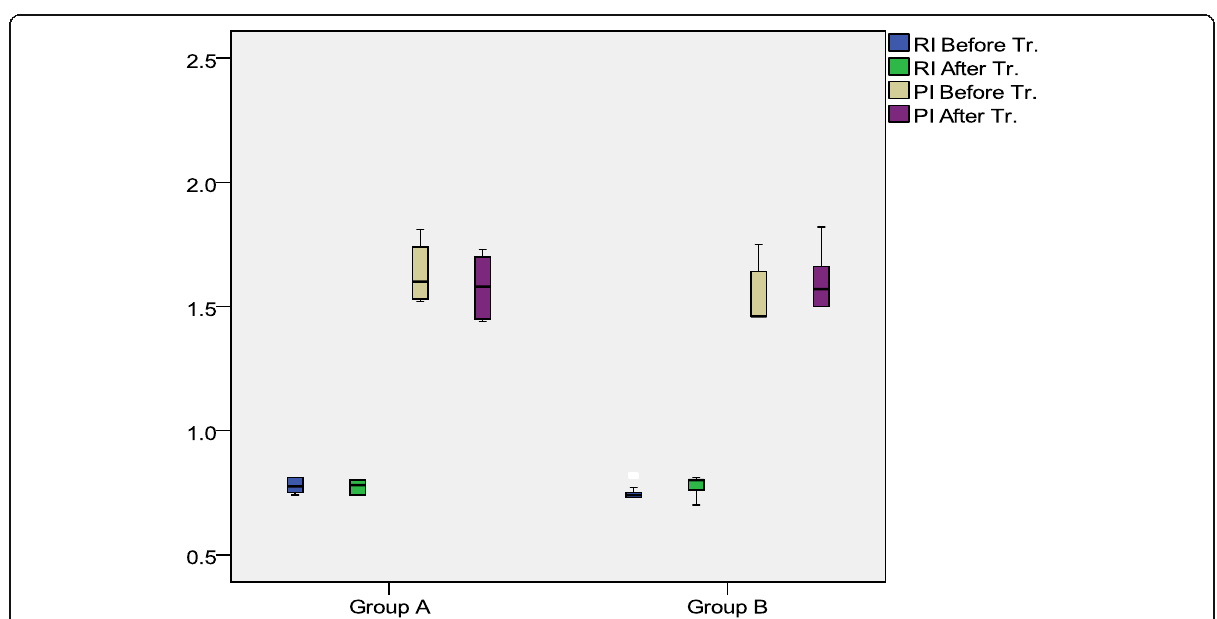
Fig. 5 Middle cerebral artery pulsatility index (PI) and resistance index (RI) before and after treatment in both groups